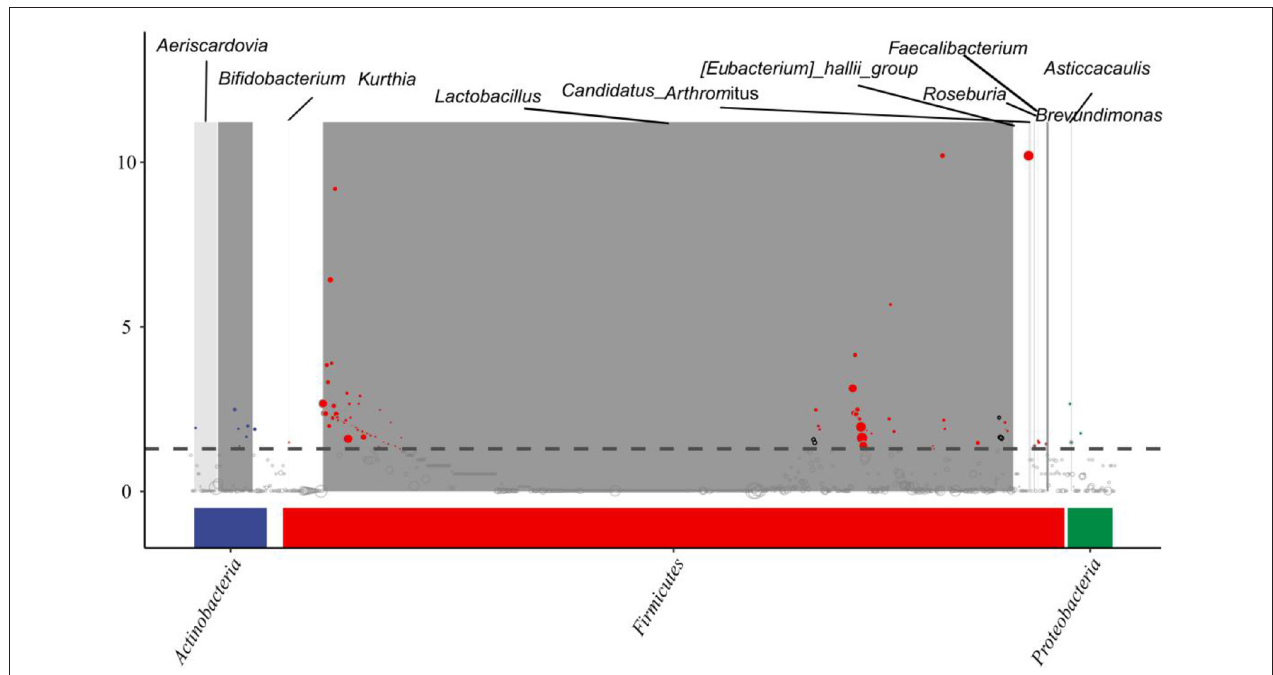
FIGURE 6 | MetagenomeSeq interpretation of the results. Significant differences were marked by colored dots or rings, non-significant differences were represented by gray